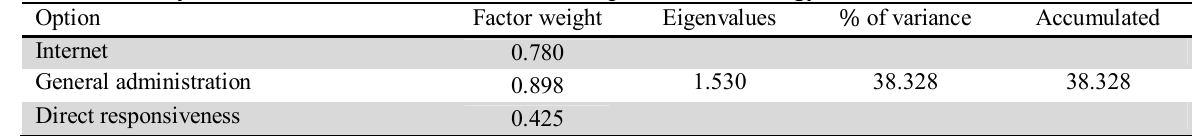
The summary of factors associated with relationship oriented